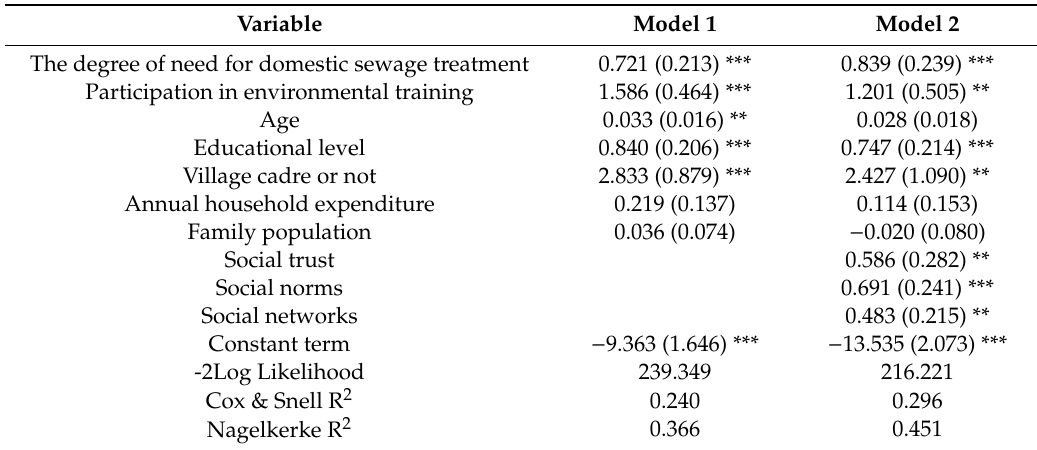
Table 3. Estimated results of influencing factors on farmer’s participation